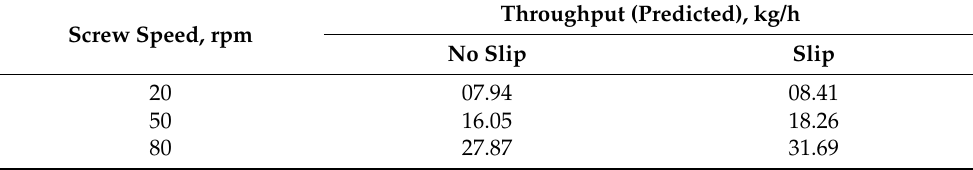
Table 1. Research program.